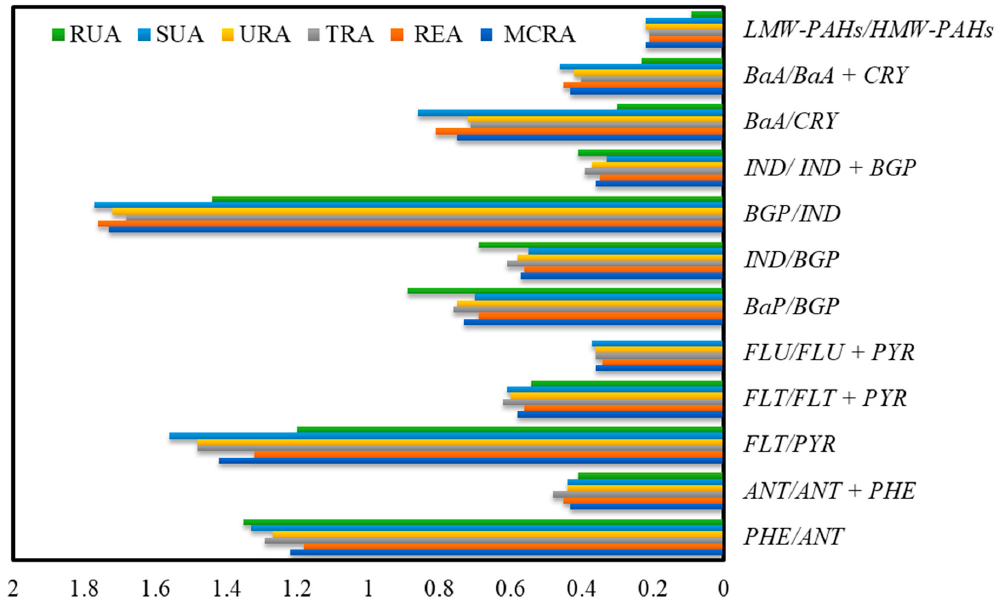
Figure 3. Diagnostic concentration ratios of selected PAH compounds in surface street dust collected from different land use patterns of Jeddah and a rural area (RUA) of Hada Al Sham. Lohmann et al. [94] reported that a BaA/CRY ratio higher than 0.40 suggests that the PAHs